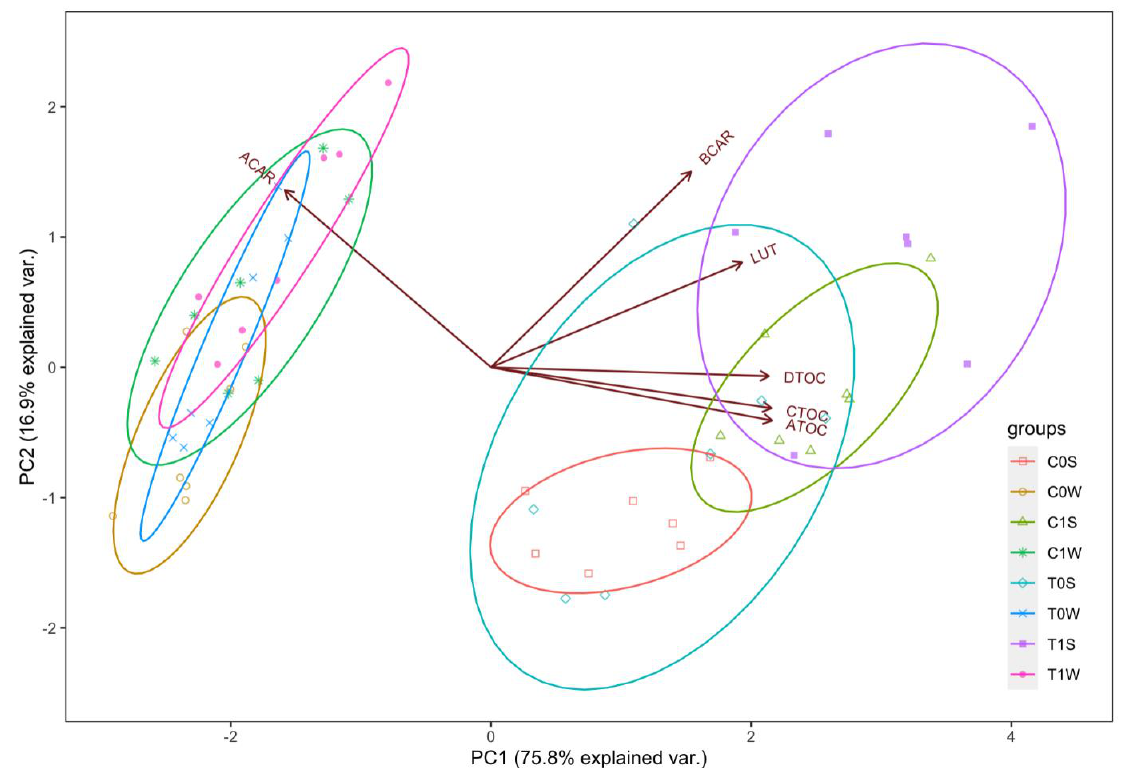
Figure 1. Biplot 2D−graph for the principal component analysis (PCA) of all 56 samples of “Ragusano” cheese; the first two principal components represented as PC1 and PC2 explain 92.7% of the total variance. Vectors represent the general variance of the variables (loadings) with respect to the samples represented by spots (scores) distributed in the graph. Even in this unsupervised scattering mode, it is evident the statistical trend of the six antioxidant species, moreover, ellipses clusters samples coming from control (C) or enriched (T) diet; before (0) or after (1) grazing pasture; produced in winter (W) or spring